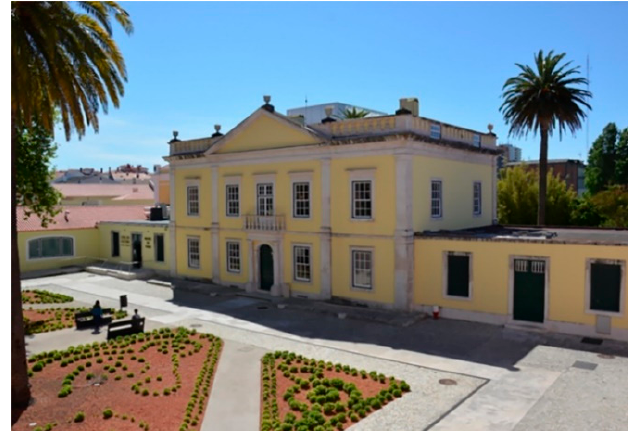
Figure 7. Portuguese Glass Museum, history of glass in Portugal exhibition. House of Guilherme Stephens: Photo credit: Câmara Municipal da Marinha Grande.